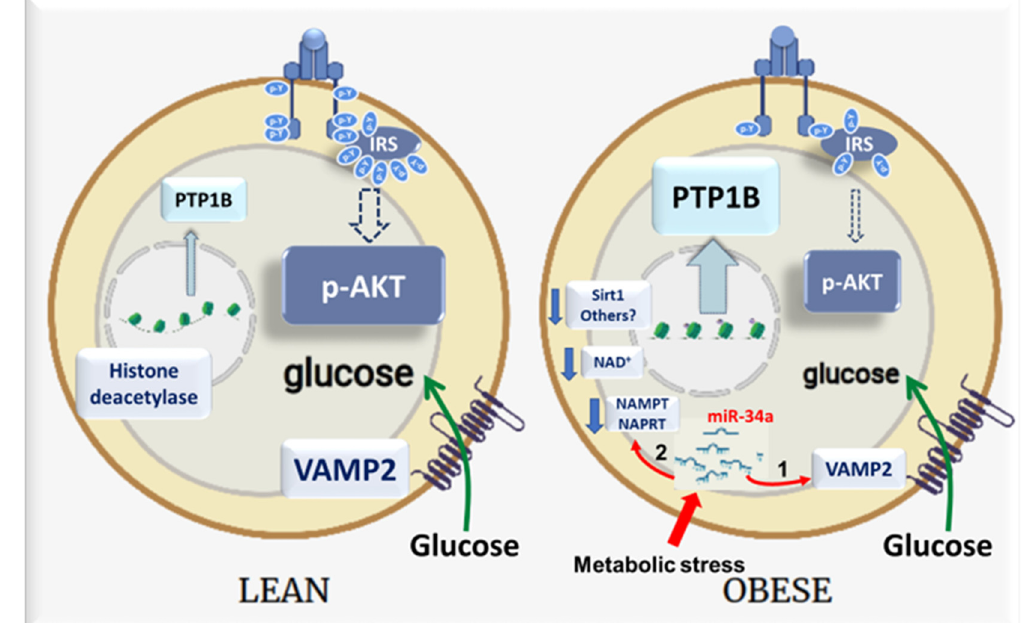
Figure 8. Schematic models illustrating the inhibitory mode of action of miR-34a on insulin signaling and glucose uptake in adipocytes during obesity. The miR-34a expression in adipocyte is low in lean state, insulin efficiently induces insulin receptor (IR) and insulin receptor substrates (IRS) tyrosine phosphorylation, leading to AKT phosphorylation and activation. Consequently, insulin increases glucose transport in adipocytes. In obese conditions, metabolic stresses increase the expression of miR-34a in adipocytes. The increase in miR-34a expression ( 1 ) inhibits the expression of the v-SNARE VAMP2 (vesicle associated membrane protein 2) involved in the fusion of GLUT4-containing vesicles with the plasma membrane and ( 2 ) inhibits the expression of NAMPT and NAPRT, leading to a decrease in NAD + level, which results in an increase in acetylation of histones, possibly due to the inhibition of Sirt1 activity, a NAD + -dependent deacetylase. This is correlated with an increase in the expression of the tyrosine phosphatase PTP1B, which plays a pivotal role in the decrease in the tyrosine phosphorylation of IR and IRS induced by miR-34a, leading to a decrease in AKT activation. The defect in insulin signaling together with the decrease in VAMP2 expression are responsible for defective glucose transport in response to insulin in adipocytes overexpressing miR-34a.